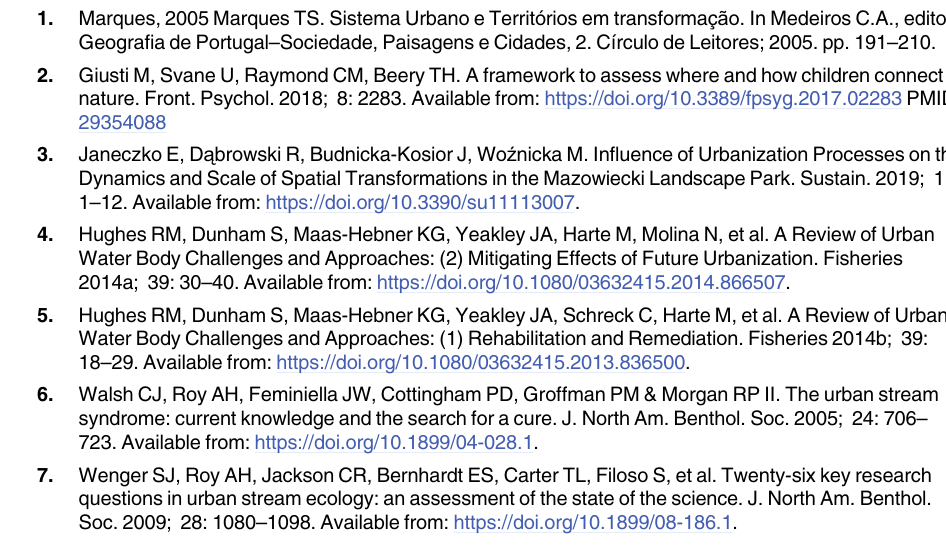
S1 Table. List of questions made in the three questionnaires (M1, M2, M3) to the students and used as variables in data